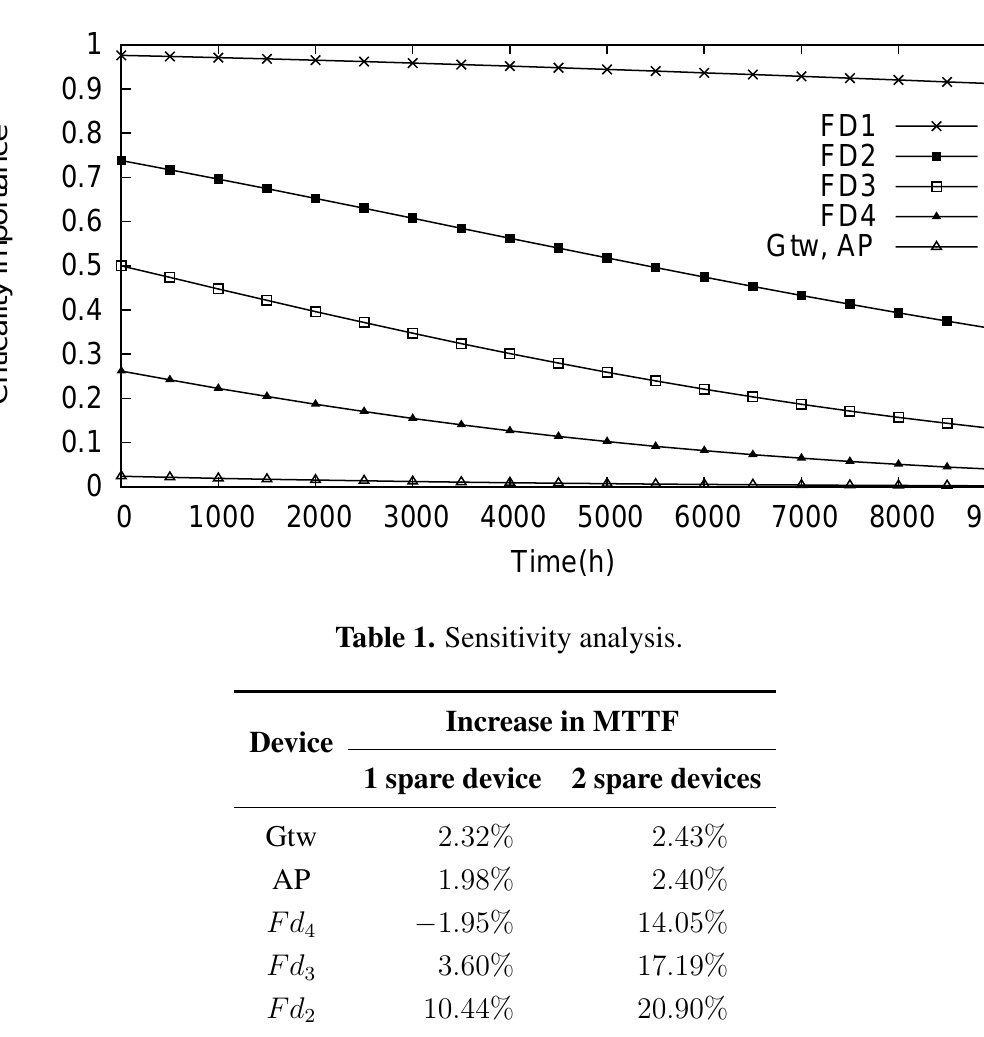
Figure 19. Analysis of the component importance based on Criticality measure for the line topology.